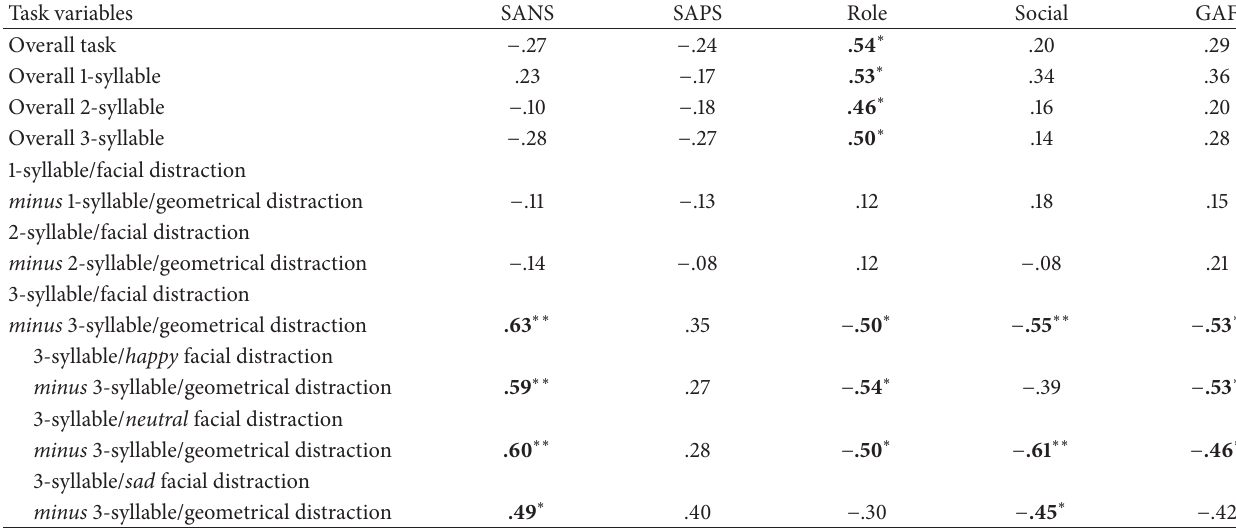
Table 1: Correlations among task variables (percent-correct), symptom severity, and functional outcome ( 𝑛 = 21